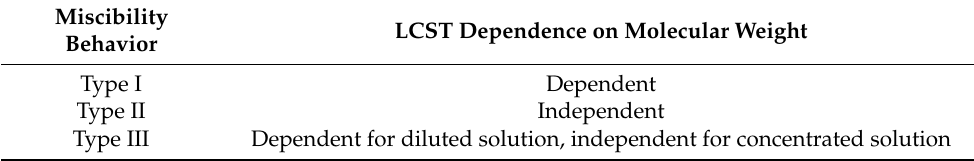
Table 2. Molecular weight dependency of LCST based on the type of miscibility